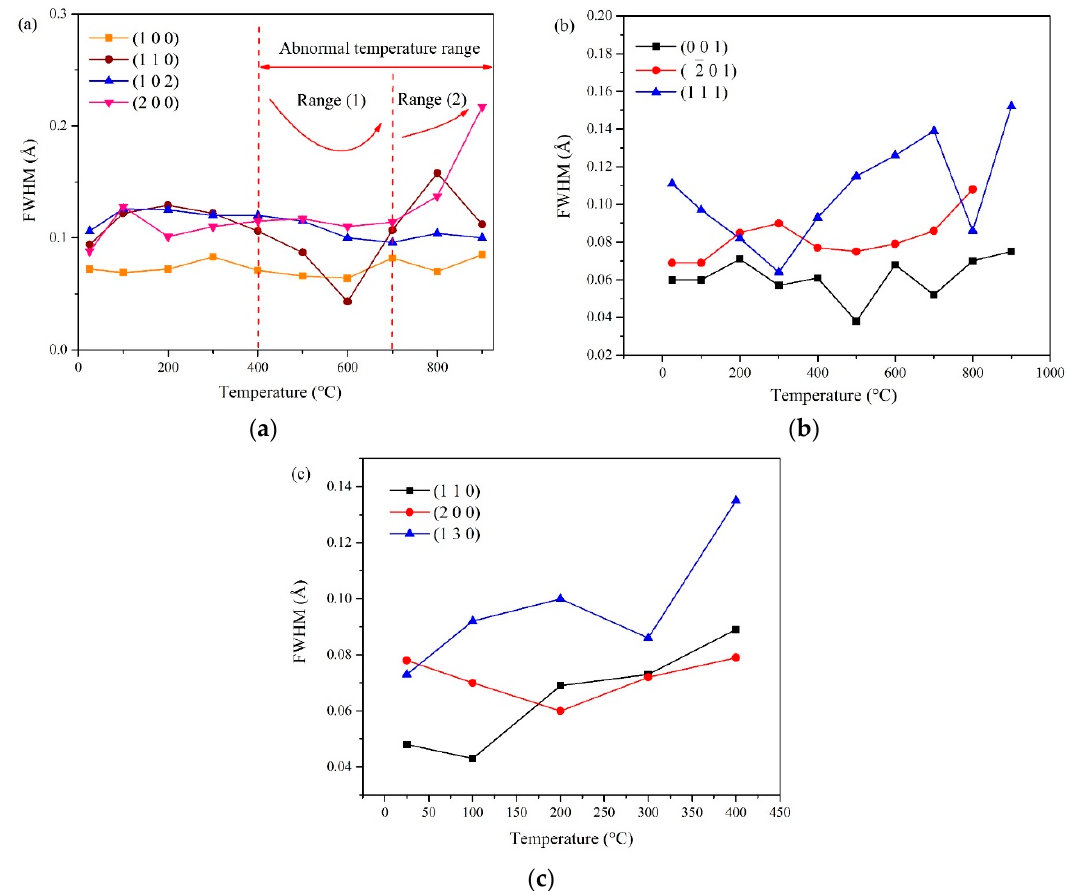
Figure 3. The FWHM curves of crystal surface of ( a ) quartz; ( b ) albite; and ( c ) laumontite.